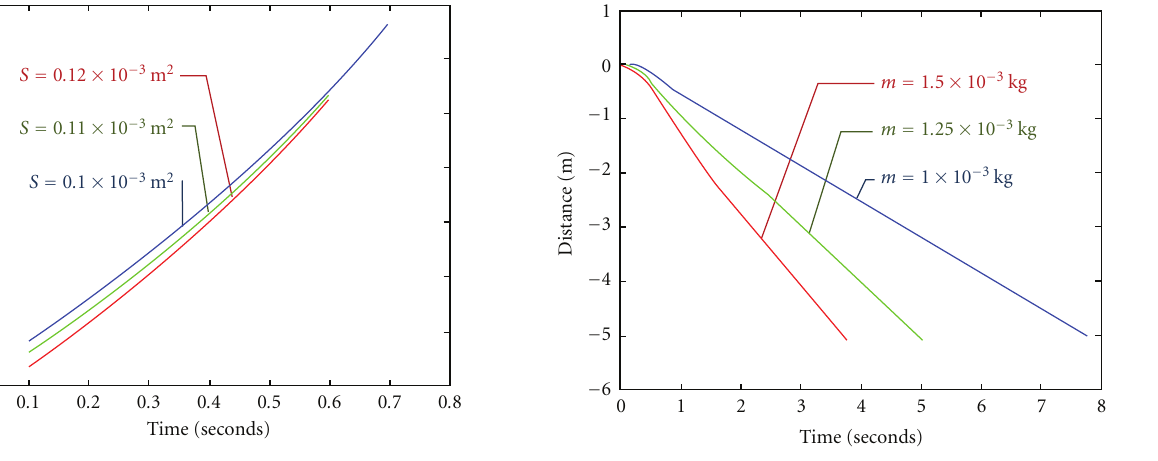
Figure 9: Dragonfly gliding down—changing the weight. Distance versus